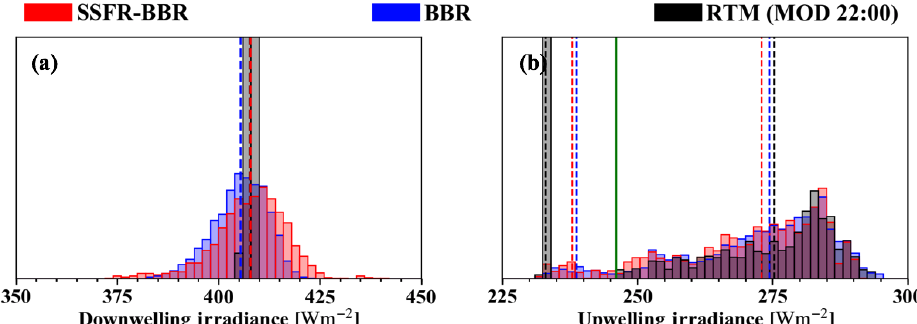
Figure 8. Histograms of broadband (a) downwelling and (b) upwelling irradiance from SSFR–BBR (red), BBR (blue), and MODIS COPs (black, Terra MODIS at 22:00) RTM calculations on 11 September (above clouds). Only “cirrus-free” data (marked in green in Fig. 7a) is included. For (a) , the mean values of BBR, SSFR–BBR, and RTM calculations are indicated by the colored dashed lines. For (b) , the mean is calculated for each of the two modes separated by the green line and indicated by the colored dashed lines.